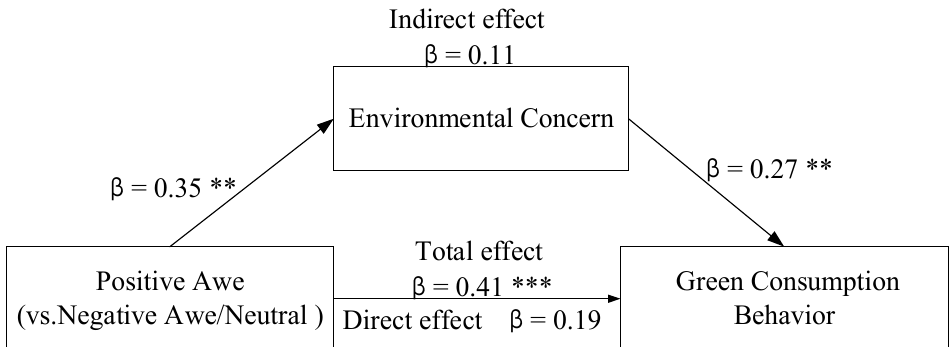
Figure 1. Mediation analysis of environmental concern. ** p < 0.01, *** p <